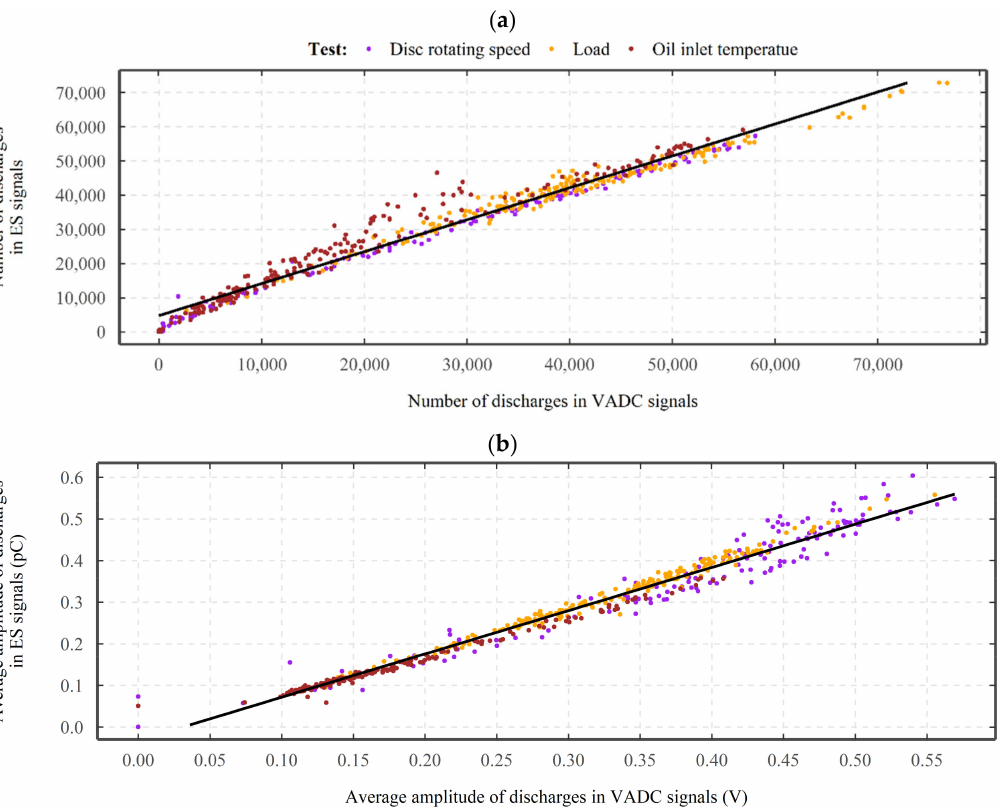
Figure 13. ( a ) Number and ( b ) amplitude of discharges, detected in the bottom ES sensor’s signals as a function of those detected on the VADC signals, for the disc rotating speed (magneta), load (yellow), and oil inlet temperature (red)